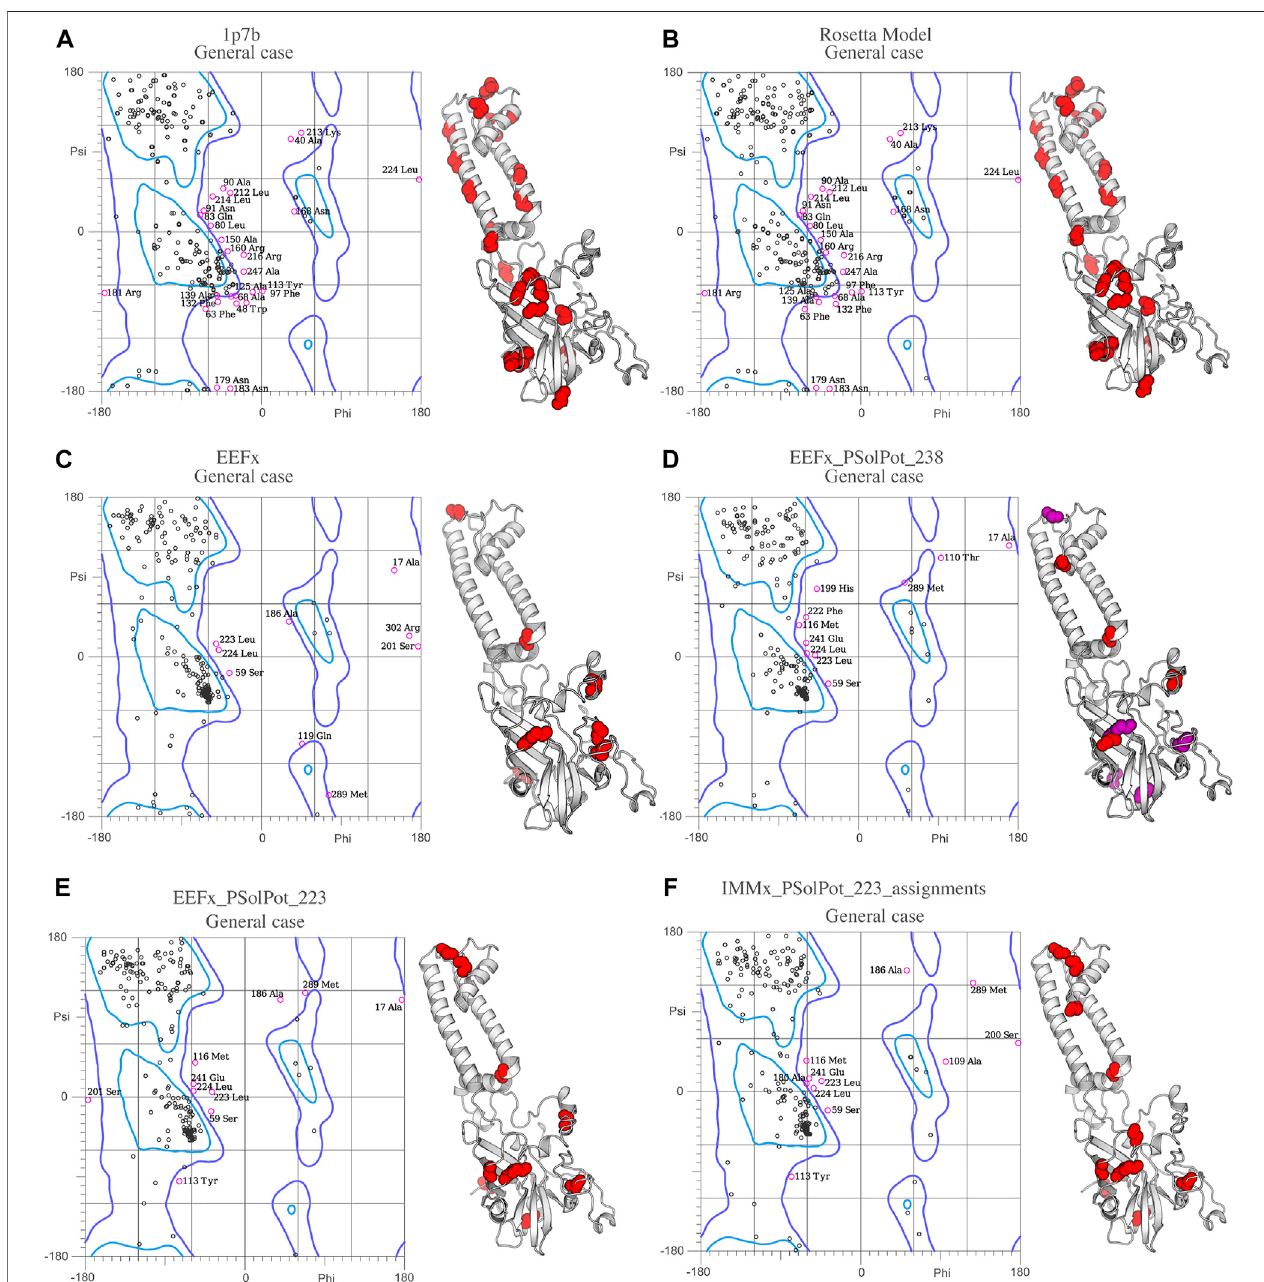
FIGURE 4 | Ramachandran space of (A) Crystal structure 1p7b, (B) Initial Rosetta model, (C) Lowest structure of EEFx run, (D) The lowest energy structure of PSolPot, residuesinmagentaaretheoutlierresidues inRamachandranspace thathasbeendeletedinthelastround ofstructurecalculationviaPSolPot. (E) Thelowest energystructurewithoutRamachandranoutlierinPSolPotlistwithEEFxpotentialterm. (F) ThelowestenergystructurewithoutRamachandranoutlierinPSolPotlistwith IMMx potential term.